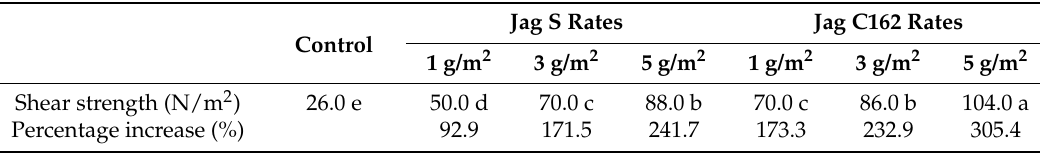
Table 2. Effect of Jag S and Jag C162 on soil shear